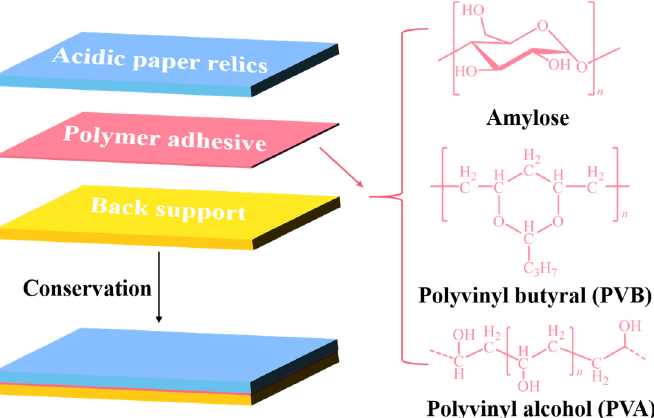
Figure 1. Schematic illustrations of paper conservation steps, and the molecular structures of polymer adhesives.